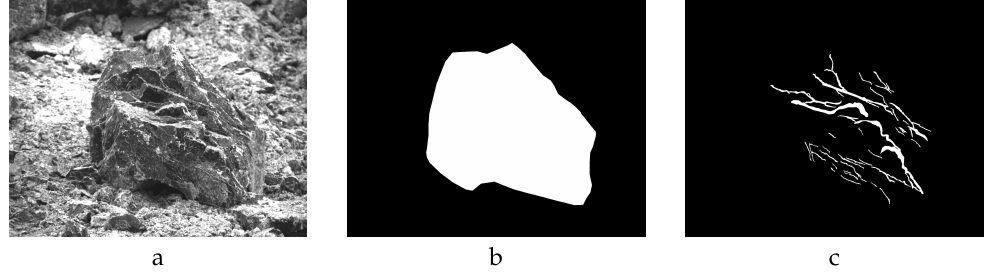
Figure 6. The typical image ( a ), its labelled mask of alone rock chunks boundaries ( b ), and veins ( c ) for the dataset №